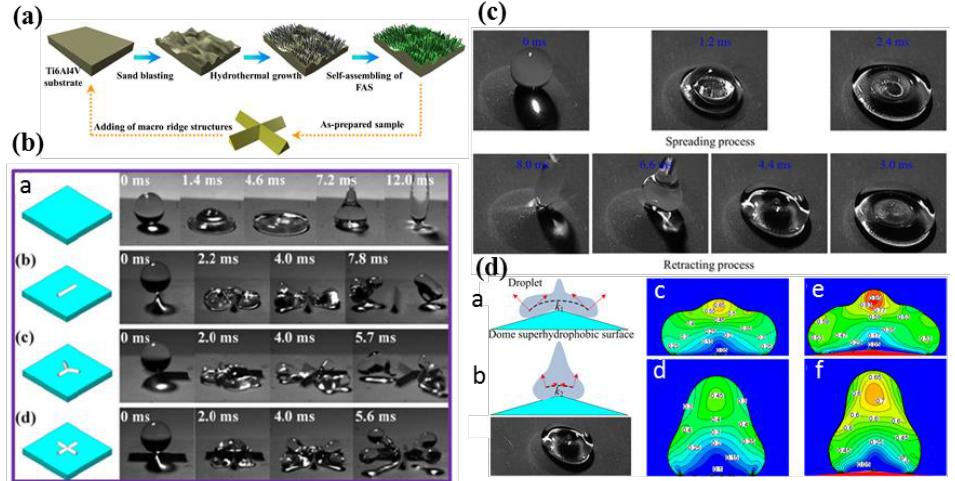
Figure 15. ( a ) The schematic illustration of the fabrication of the ultra-water-repellent surface; ( b ) The macro ridge structures on the as-prepared superhydrophobic surface, and the corresponding contact processes of the impact water droplet [140] (copyright © 2016 Elsevier B.V.); ( c ) The moving process of the impact droplet at We = 6.87 until bouncing off the convex superhydrophobic surface; and ( d ) The schematic illustration of forced direction variation from stage k1 to stage k2 during the retracting process (a,b). The numerical results of impact droplet retracting at the two particular moments on the flat (c,d) and dome convex (e,f) surfaces. (Adapted from [141] with permission; Copyright 2016 AIP).